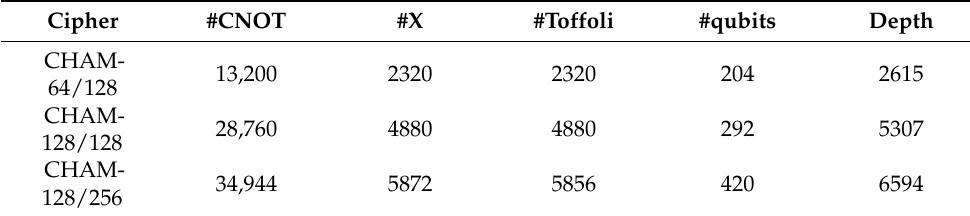
Table 2. Quantum resources required for previous CHAM implementation (JSKKKS’20).